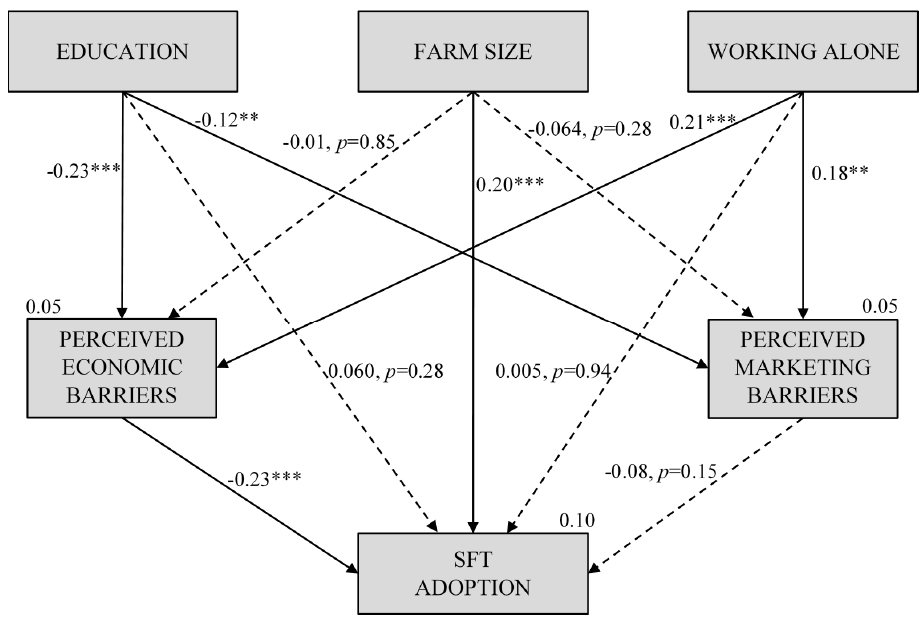
Figure 2. The final mediated model: the actual use of SFTs is predicted by working alone, farm size, education, via perceived economic barriers (significant paths in bold solid lines). Errors are omitted; standardized parameters (i.e., regression β coefficients) are displayed. Note. ** p < 0.01, *** p < 0.001